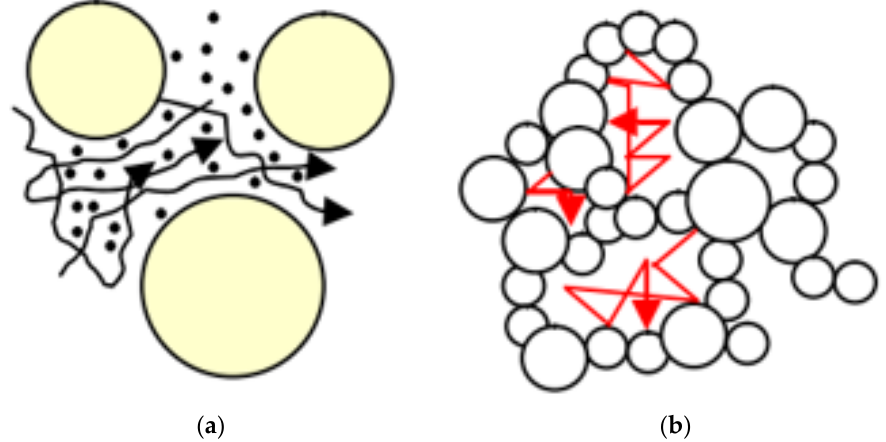
Figure 5. Gas thermal conductivity: ( a ) General porous materials; ( b ) Aerogel nano-porous materi- als.